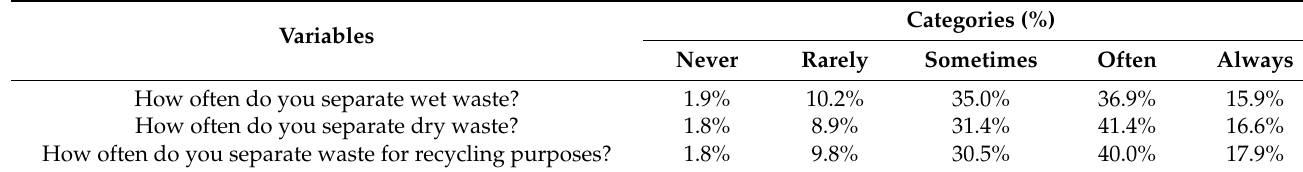
Table 2. Pro-environmental behavior and frequency (N =